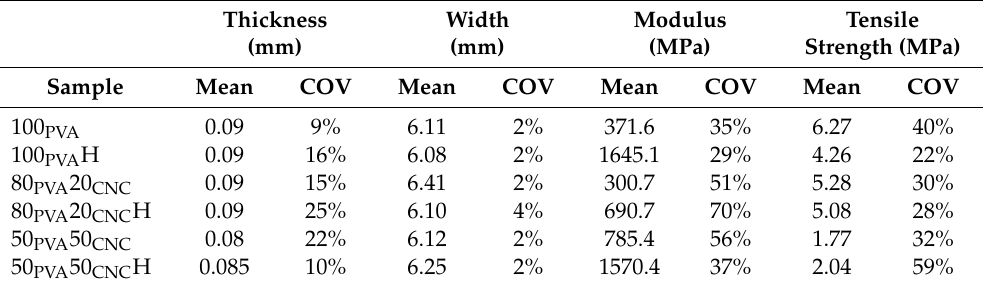
Table 3. Tensile mechanical properties for electrospun PVA (7% w / v ) and PVA / CNC composite mats with and without heat treatments. The mean and coe ffi cient of variation are reported for all three types (00, 20, 50% w / w ) and for no treatment and heat treatment (H). Thickness Width (mm) (mm)